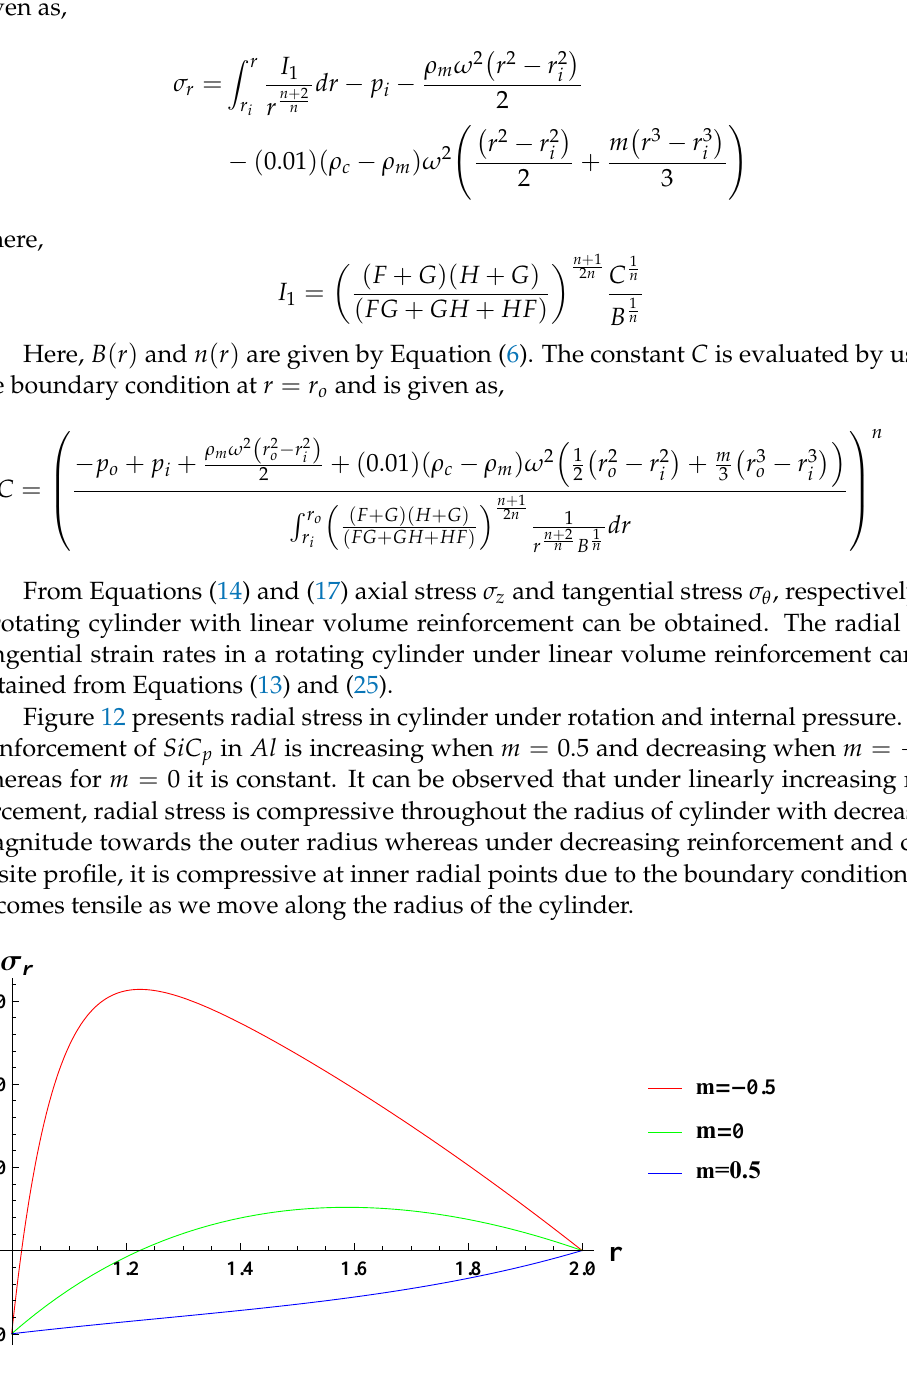
Figure 12. Radial stress (in MPa) along the radius r (in cm) of the cylinder, under the effect of rotation ( ω 2 = 50 rad/s), internal pressure p i = 50 MPa and linear volume